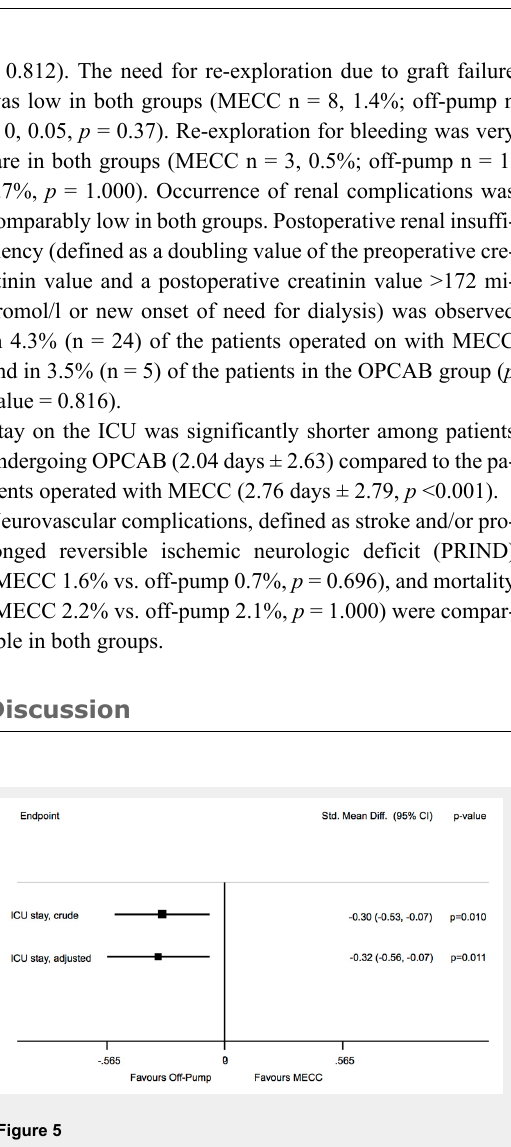
Forest plot comparing length of stay on the ICU. Forest plot regarding secondary endpoint